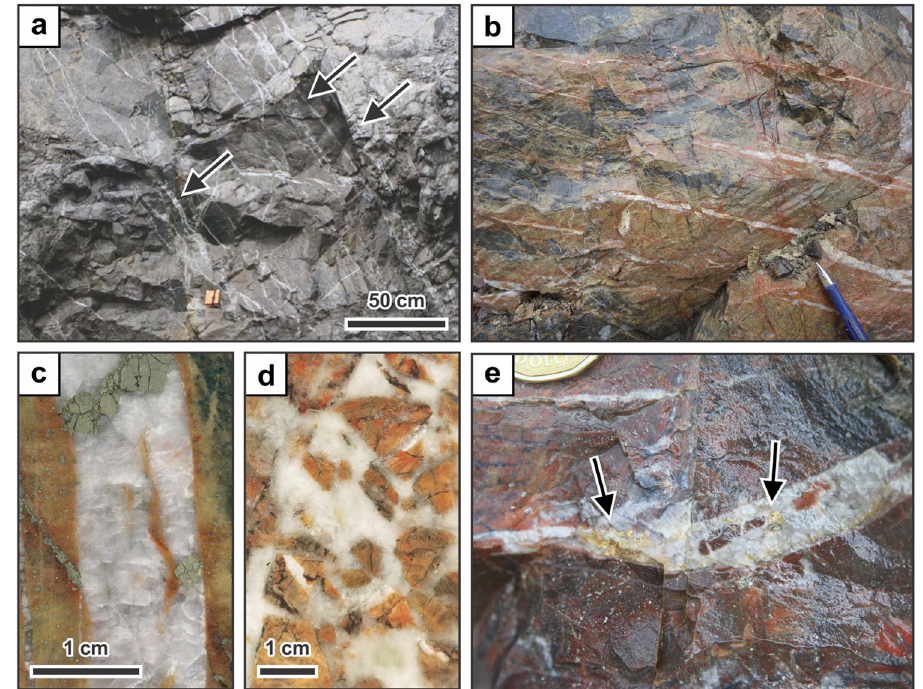
Figure 2. Characteristics of quartz veins. ( a ) E-dipping quartz veins (arrows) crosscutting metasedimentary rocks. ( b ) Extensional veins surrounded by halos of intense albite alteration. ( c ) Hand specimen of extensional quartz vein containing pyrite. The metasedimentary rock surrounding the vein is albite-altered. ( d ) Hand specimen of hydrothermal breccia cemented by quartz. The clasts of wall-rock in the breccia are intensely albite-altered. ( e ) Extensional vein containing abundant visible gold (arrows). The visible gold appears to be paragenetically late and crosscuts the quartz forming the